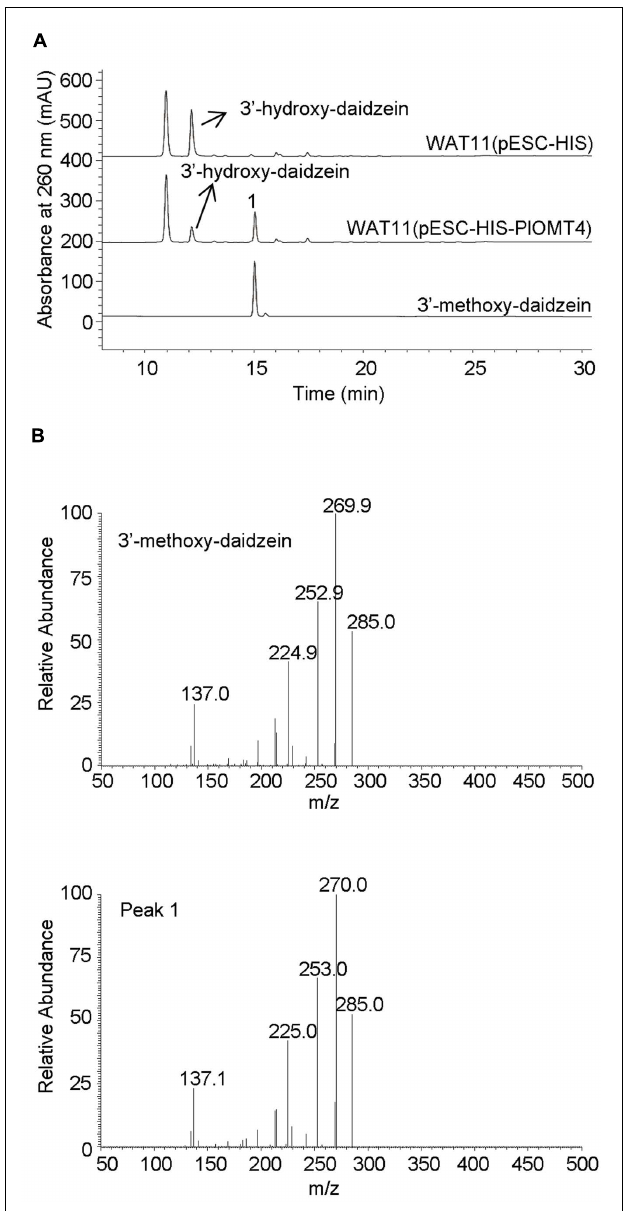
FIGURE 3 | Biochemical characterization of PlOMT4 in yeast cells by LC–MS analysis. (A) , the conversion of the substrate 3 (cid:48) -hydroxy-daidzein to 3 (cid:48) -methoxy-daidzein (peak 1) by PlOMT4; (B) , the mass spectra of the peak 1 with its authentic standard. WAT11 (pESC-HIS), the yeast strain carrying the empty vector pESC-HIS as a control; WAT11 (pESC-HIS-PlOMT4), the yeast strain expressing PlOMT4.